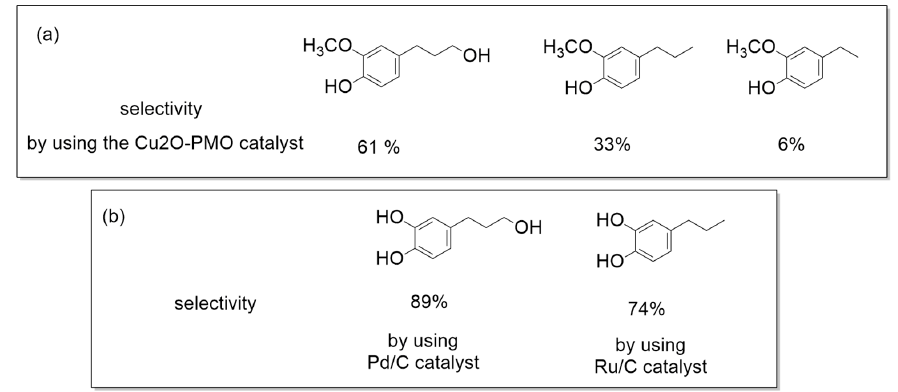
Figure 25. Monomeric phenols obtained with good selectivity by recently reported chemical treatment of lignocellulosic material. ( a ) guaicol derivatives; ( b ) catechol derivatives.